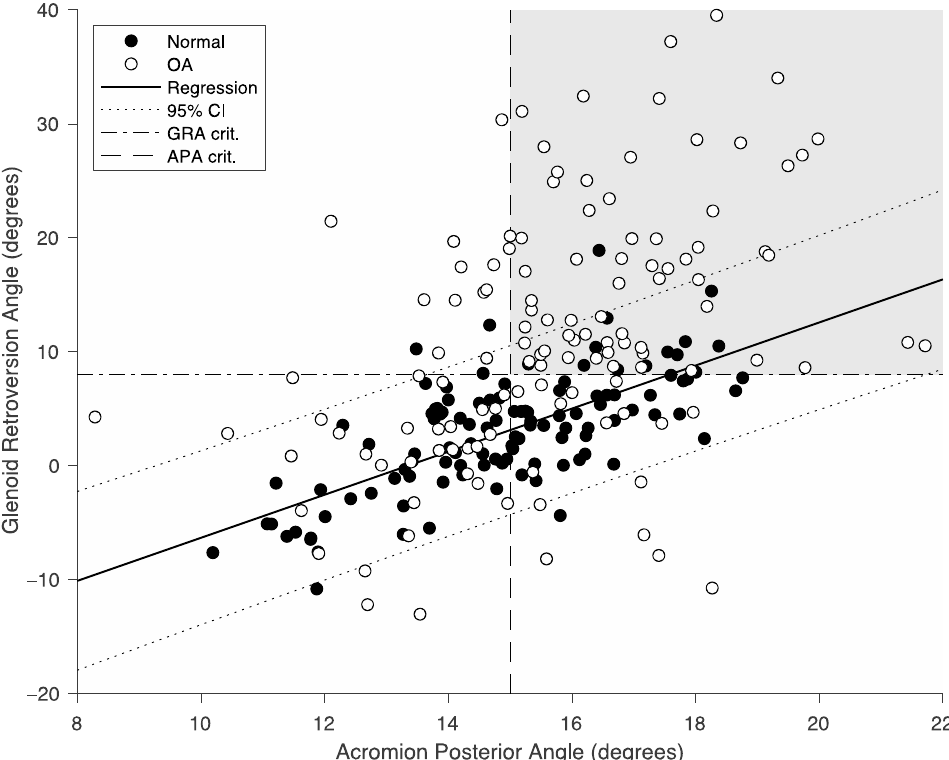
Figure 2. Measured acromion posterior angle (APA, x axis) vs. glenoid retroversion angle (GRA, y axis) for normal scapulae (black dots) and primary osteoarthritic scapulae (white dots). The continuous line represents the linear regression between the APA and GRA for normal scapulae, with its 95% confidence interval (dotted lines). The grey-shaded area (top right corner) shows the number of osteoarthritic scapulae with critical angle values (dashed lines) of APA > 15 degrees and GRA > 8 degrees. Table 2. Glenoid retroversion angle (GRA; mean ± SD) and acromion posterior angle (APA; mean ± SD) for normal and osteoarthritic scapulae, subclassified according to the updated Walch classification. Scapulae Normal (n =